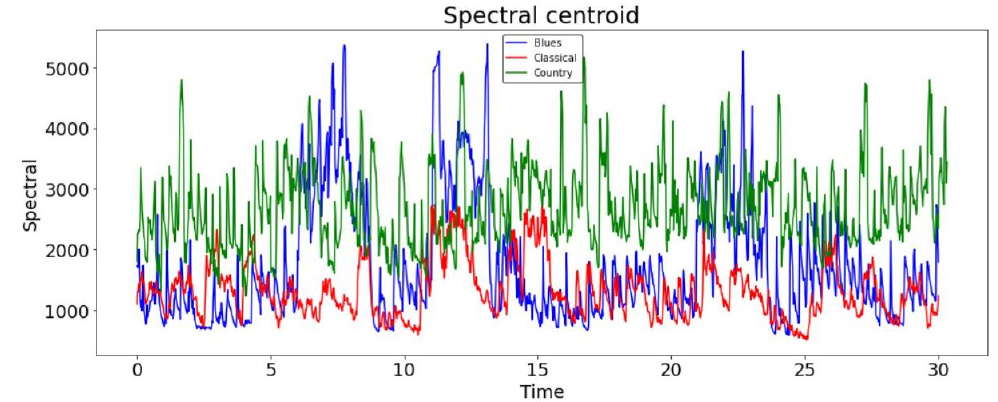
Figure 7. Spectral centroid (graphical representation) of blues, classical, and country genres. (b) Spectral bandwidth—This is represented as the calculated variance from the spec- tral centroid; see Figure 8.